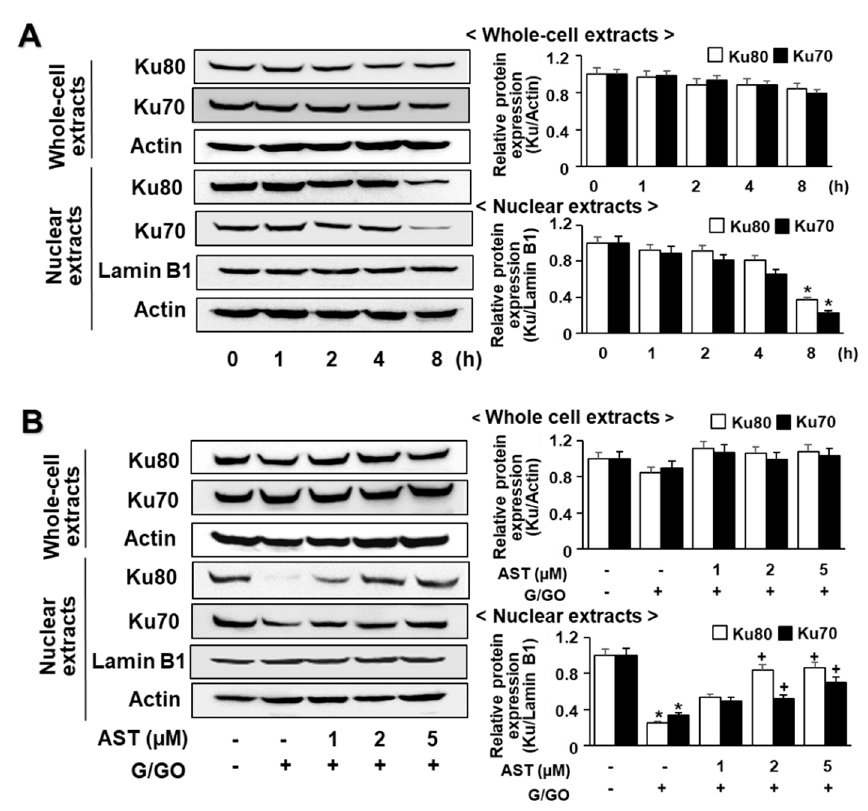
Figure 4. Astaxanthin inhibits glucose/glucose oxidase (G/GO) − induced decrease in Ku70/80 levels in whole-cell extracts and nuclear extracts in AGS cells. The cells were ( A ) treated with G/GO for the indicated time periods or ( B ) pre − treated with the indicated concentrations of astaxanthin for 3 h, followed by stimulation with G/GO for 8 h. ( A , B ) Ku70 and 80 protein levels in the whole − cell and nuclear extracts were determined by Western blot analysis using actin and lamin B1 as the loading control and nuclear marker, respectively (left panel). The densitometry data represent mean ± standard error (SE) from three immunoblots and are shown as the relative density of the actin or lamin B1 protein bands (right panel). * p < 0.05 vs. untreated cells (AST − and G/GO − ). + p < 0.05 vs. control cells (AST − and G/GO+: cells without astaxanthin treatment in the presence of G/GO). AST,